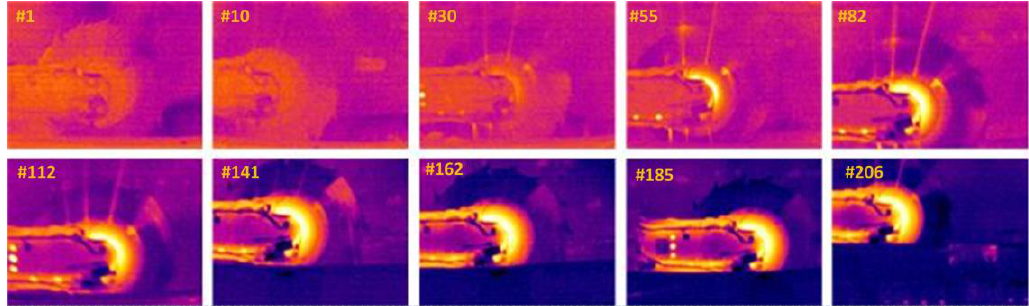
Figure 10. Infrared thermal imaging video screenshots of shearer cutting unit.